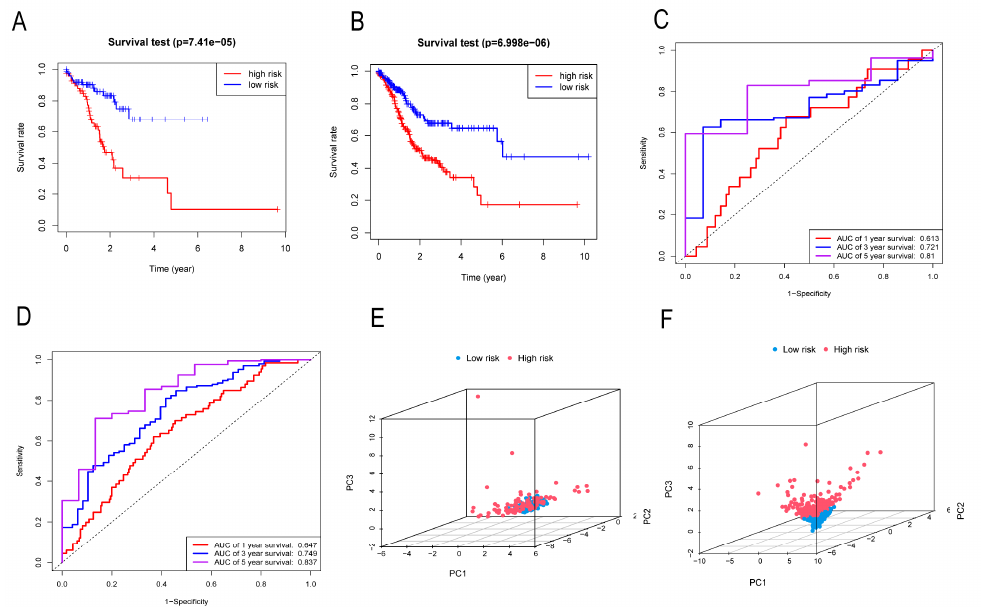
Figure 6. Validation of risk score. ( A , B ) Validation of the OS curve of Test group and TCGA complete set. ( C , D ) Test group and TCGA complete set ROC curve verification. ( E , F ) PCA verification of Test group and TCGA complete set.